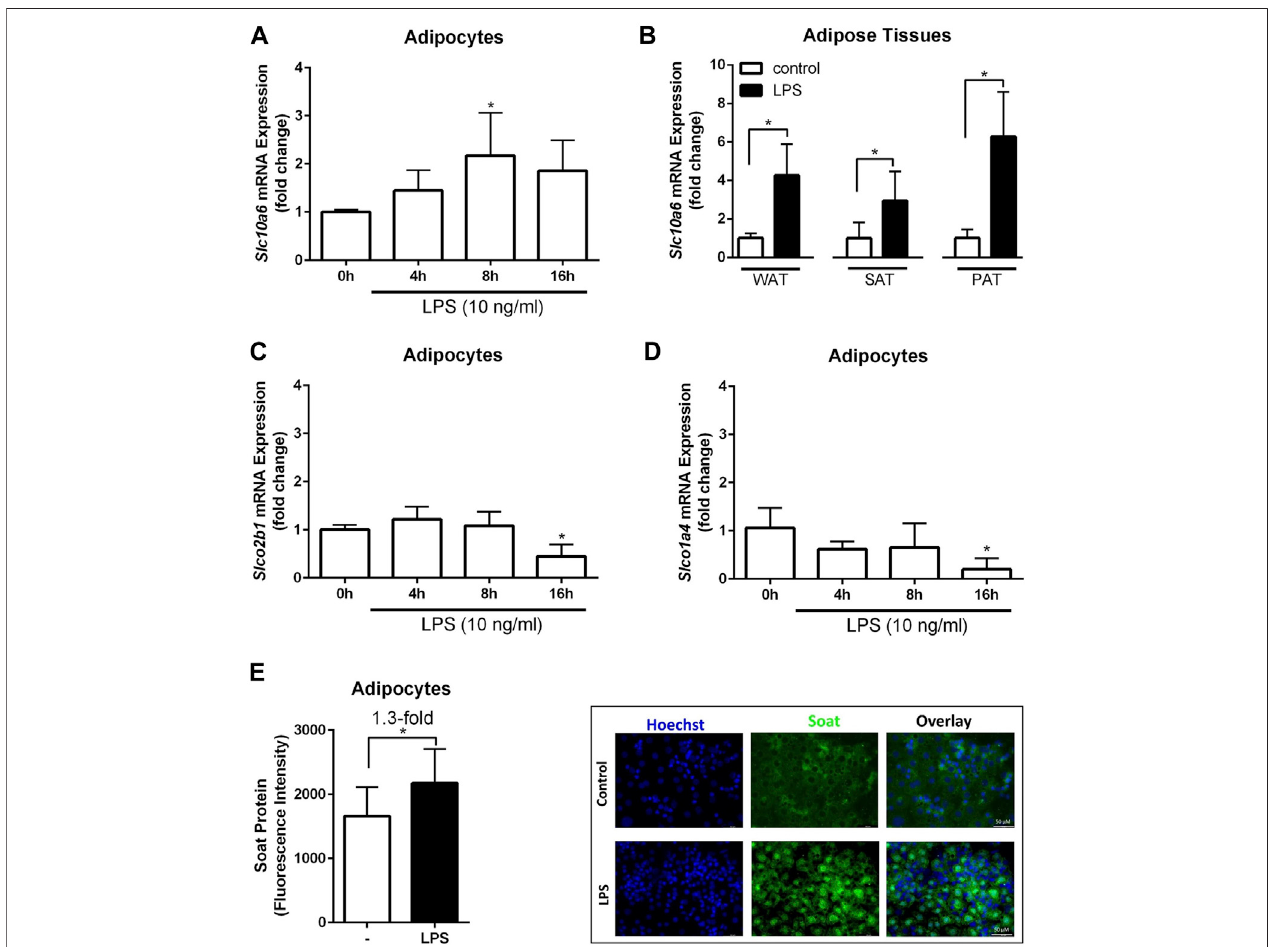
FIGURE4| ExpressionanalysisofsteroidsulfateuptakecarriersinadipocytesandadiposetissueinresponsetoLPS.ThemRNAexpressionlevelsof Slc10a6 (A) , Slco2b1 (C) ,and Slco1a4 (D) werequanti fi edusingqPCRinLPS-induced3T3-L1adipocytes.3T3-L1adipocytesweretreatedwith10 ng/mlLPSfortheindicatedtime periods.Datarepresentmeans±SDoftriplicatedeterminationofrepresentativeexperiments (B) Slc10a6 mRNAexpressioninLPS-treatedmiceforWAT,SAT,andPAT (n = 6). Data represent means ± SD. All carrier mRNA expression levels were normalized to Gapdh expression. Soat protein expression in (E) represents means ± SD of three independent areas of view (each with 60 – 74 cells) of three independent replicates. The mature adipocytes were treated with 10 ng/ml LPS for 24 h. Representative immuno fl uorescence images are shown. Cells were fi xed and stained with the anti-Soat antibody and the secondary Alexa Fluor 488 goat anti-rabbit antibody (green fl uorescence). Hoechst 33342 was used for nuclei staining (blue fl uorescence). *Signi fi cant differences indicated by p < 0.05 using one-way ANOVA (A , C and D) orStudent ’ st-test (B and E) .LPS,lipopolysaccharide;WAT,whiteintra-abdominaladiposetissue;SAT,subcutaneousadiposetissue;PAT,perirenaladipose